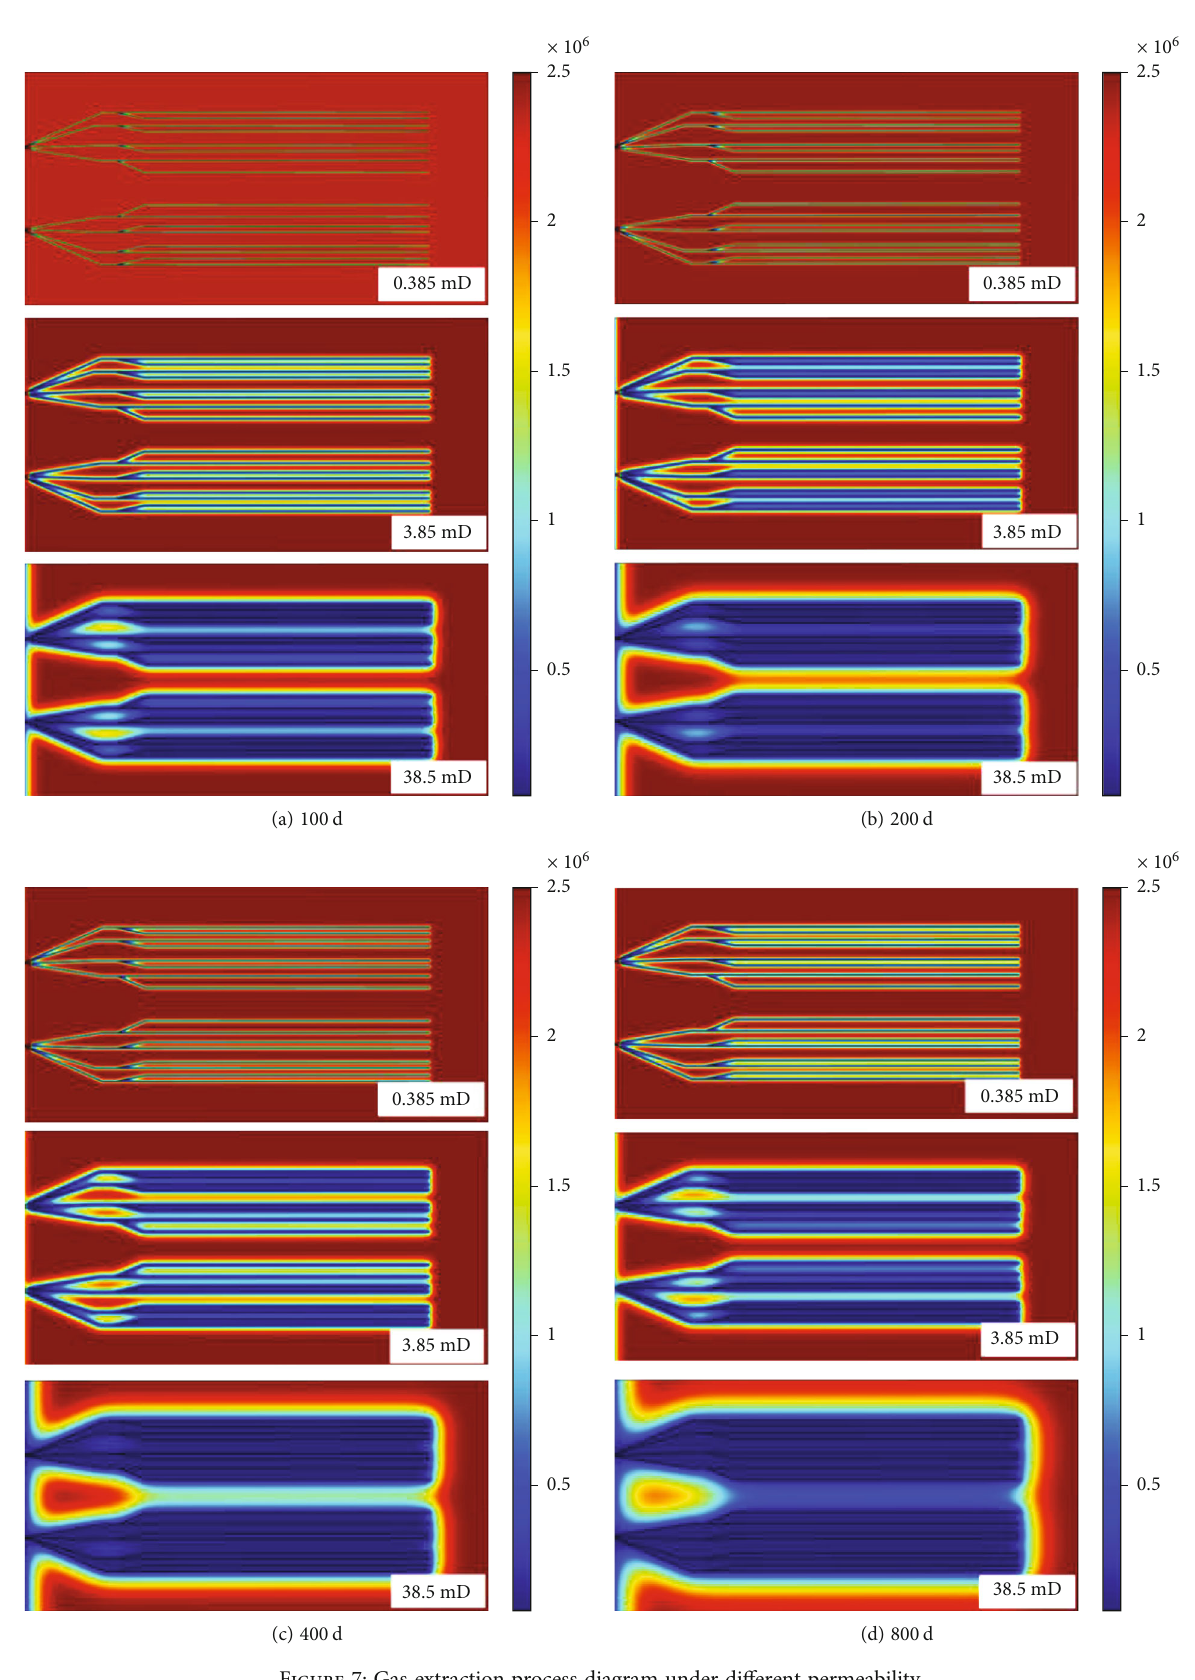
Figure 7: Gas extraction process diagram under di ff erent